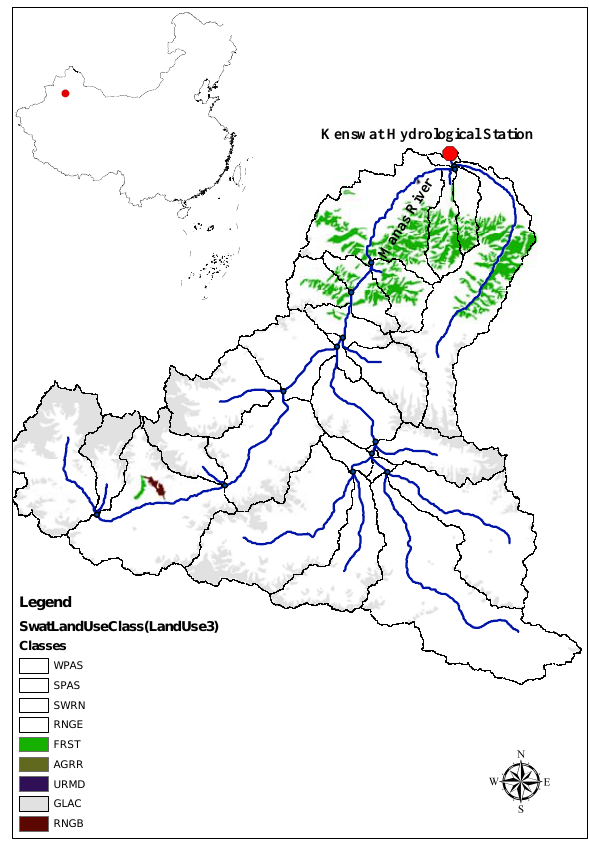
Fig. 2. The Manas River basin and subbasin delineation map (the Fig. 2 The Manas River basin and subbasin delineation map (the upper-left small figure is the 2 upper-left small figure is the sketch map of China indicating the location of the study sketch map of China indicating the location of the study area) 3